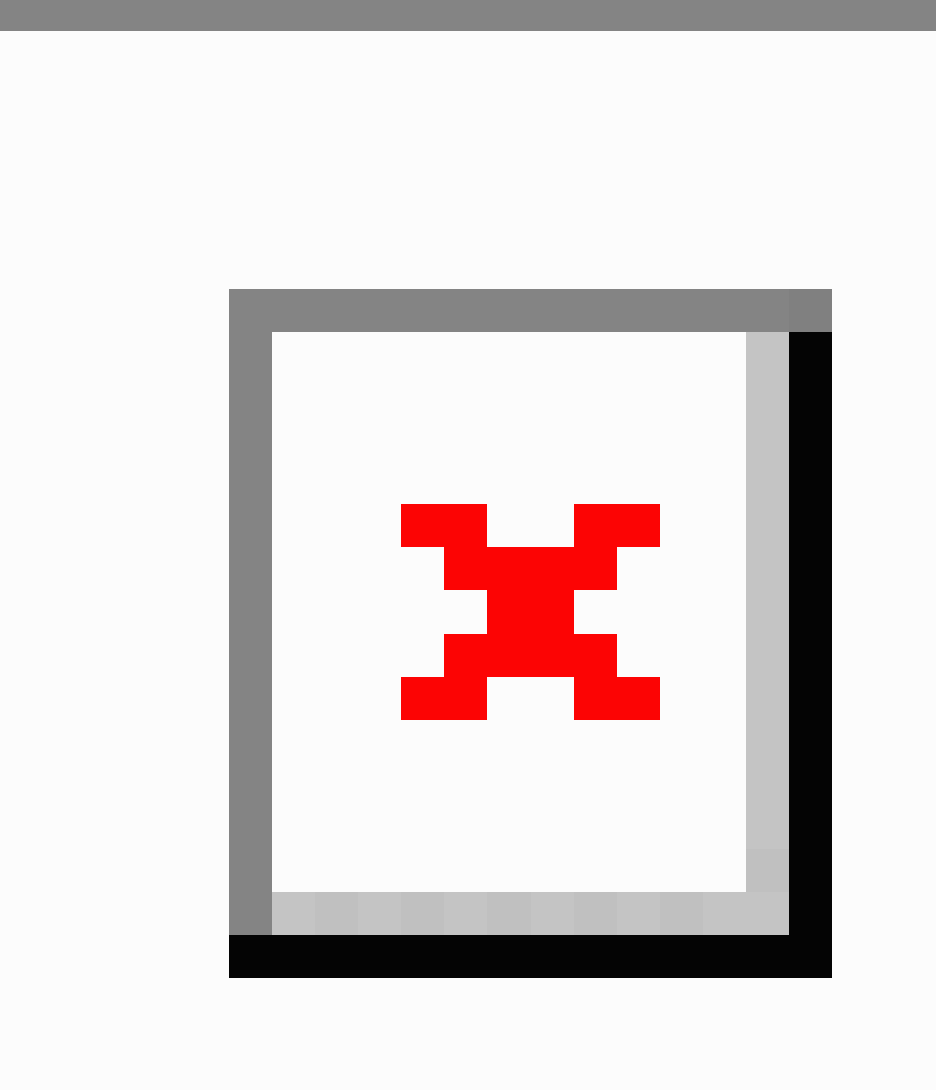
Non-Adherence Exercise